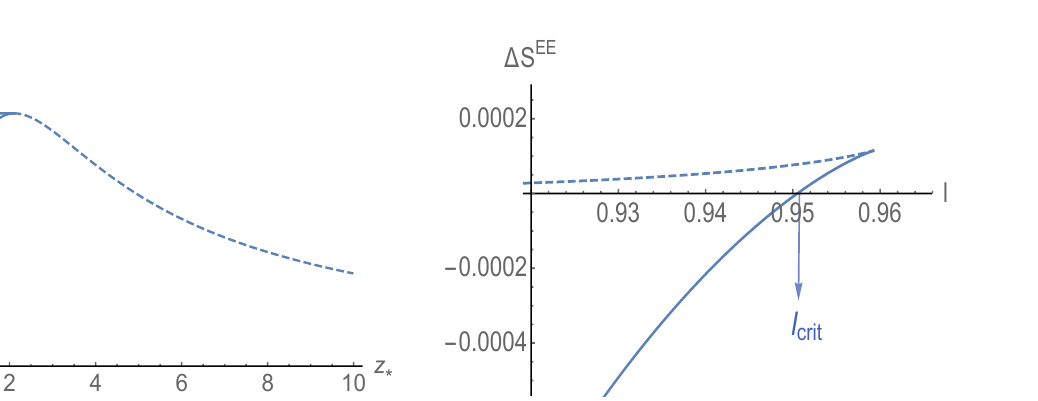
Figure 3 . ‘ as a function of z (cid:3) in the thermal- AdS background. In units GeV.